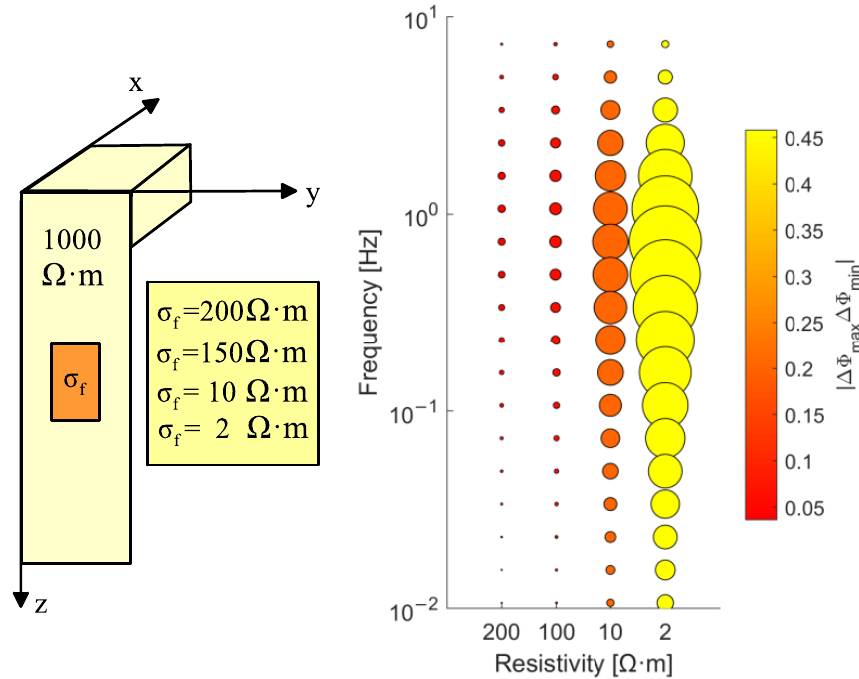
Figure 6. Fracture isotropic model and residual phase tensor results.